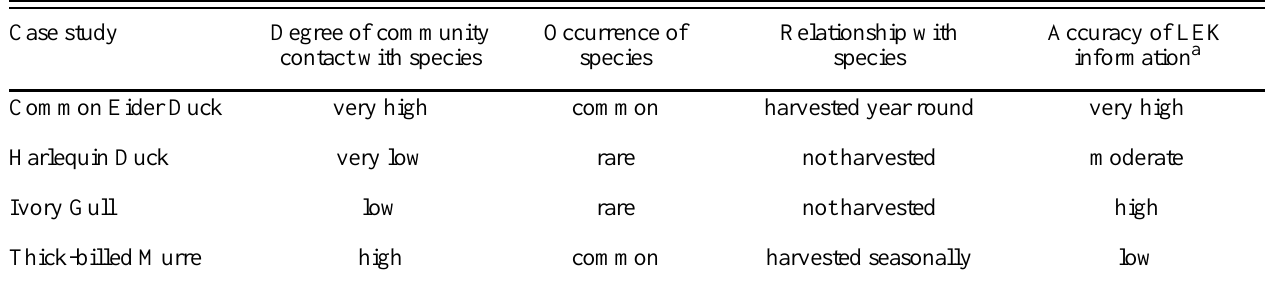
Table 1 . Summary of LEK information provided in relation to degree of community contact with a species. Case study Degree of community Occurrence of Relationship with Accuracy of LEK contact with species species species information a Common Eider Duck very high common harvested year round very high Harlequin Duck very low rare not harvested moderate Ivory Gull low rare not harvested high Thick-billed Murre high common harvested seasonally